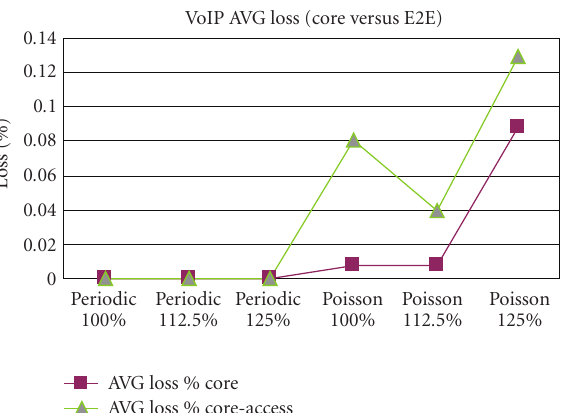
Figure 19: VoIP loss percentage AS addition.